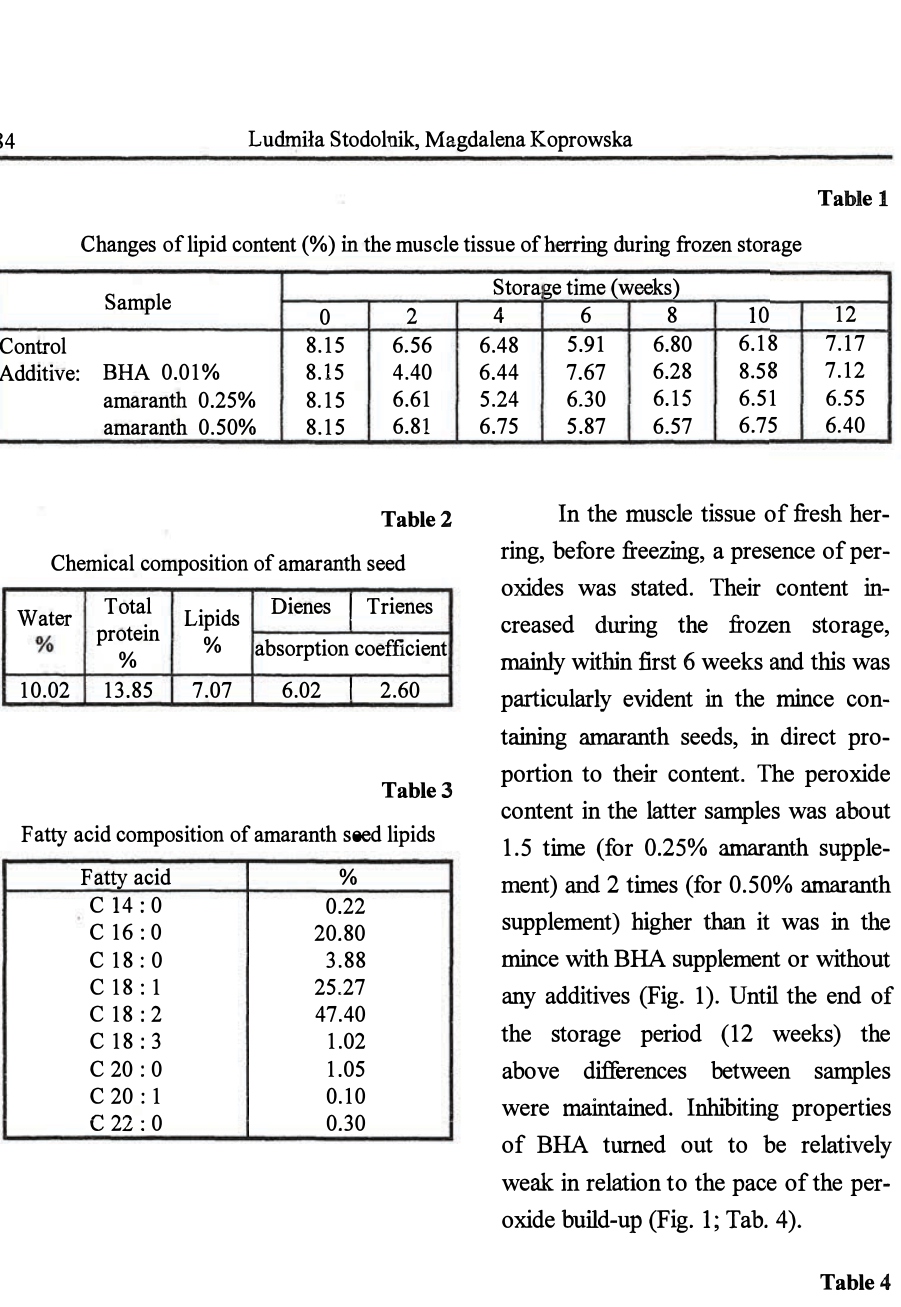
Antioxidative activity(%) of the additives used to the muscle tissue of herring during frozen storage Malon- Additive Hydroperoxides Dienes Trienes Total dialdehyde BHA